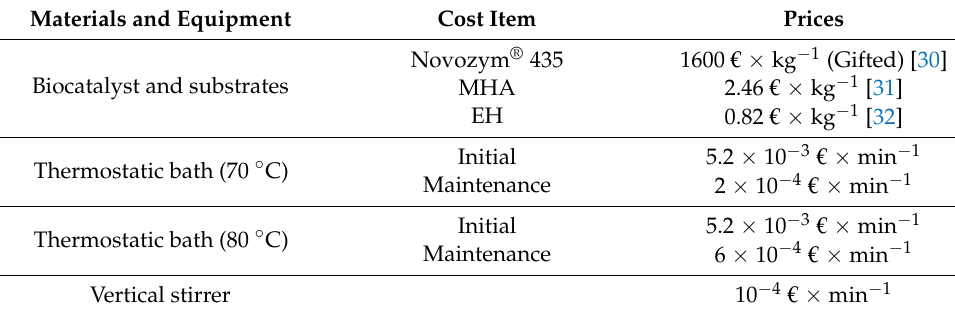
Table 4. Costs of the biocatalyst, substrates and